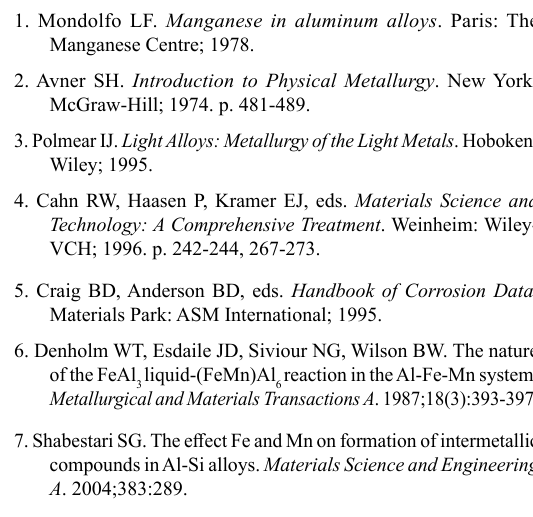
lower the ductility. Thus, as iron level increases, impact on